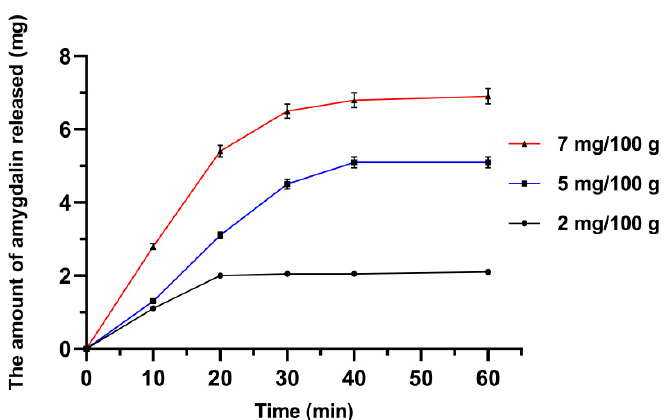
Figure 18. The amount of amygdalin released over time in solution after